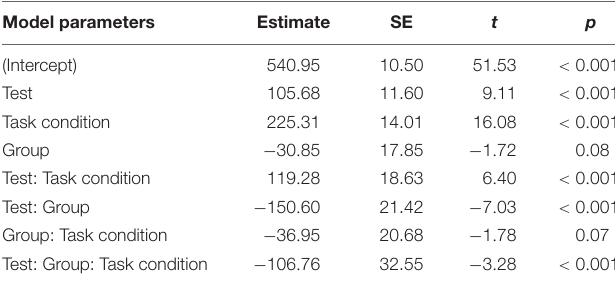
Model parameters